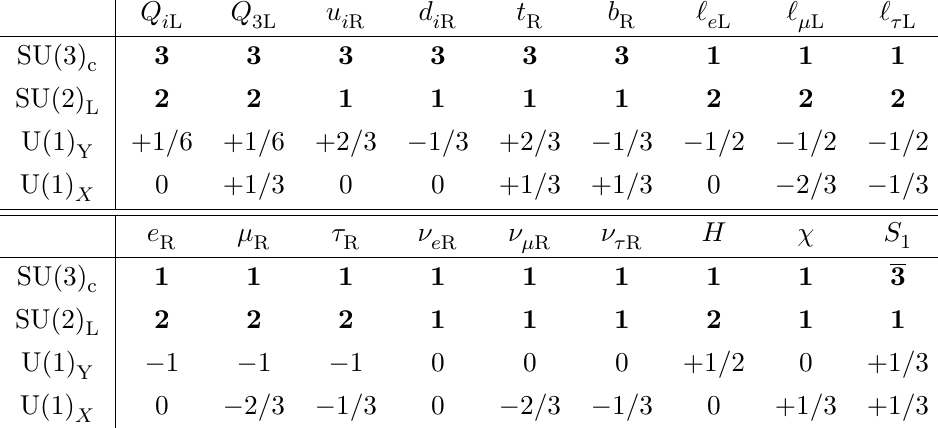
Table 1 . Charge assignments of the SM particles, three right-handed neutrinos ν the S leptoquark and the flavon χ under the SU(3) 1 where the indices i = 1 , 2 of { Q denotes the SM Higgs